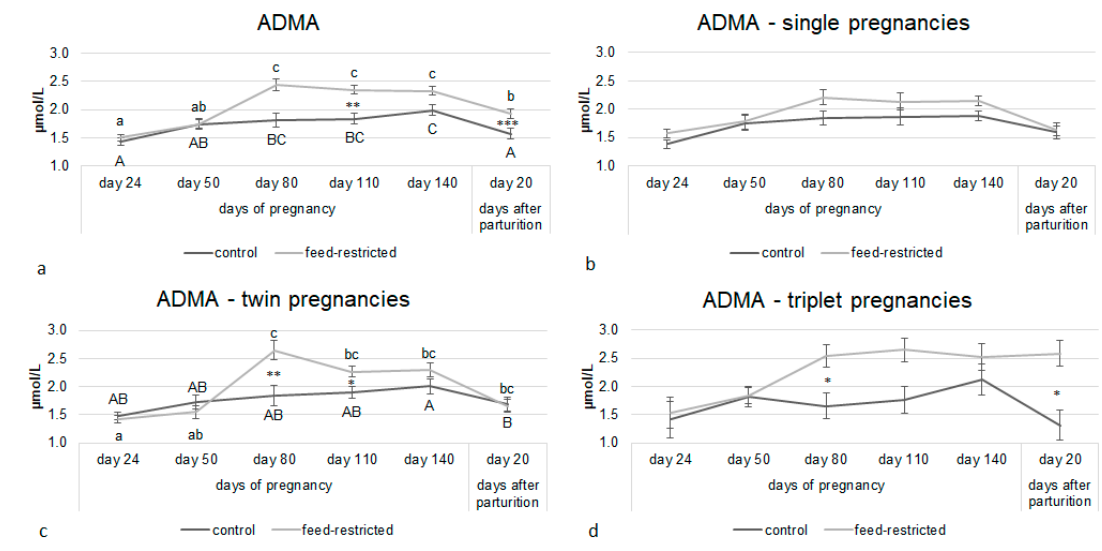
Figure 3. Asymmetric dimethylarginine (ADMA) circulating concentrations from day 24 of pregnancy to day 20 after parturition in control and feed-restricted ewes ( a ) carrying single fetuses ( b ), twins ( c ), and triplets ( d ). Asterisks indicate significant differences between control and feed-restricted ewes: ANCOVA * p < 0.05, ** p < 0.01; *** p < 0.001. Different letters indicate significant differences within the same group: Upper-case letters for control group and lower-case letters for feed-restricted group.